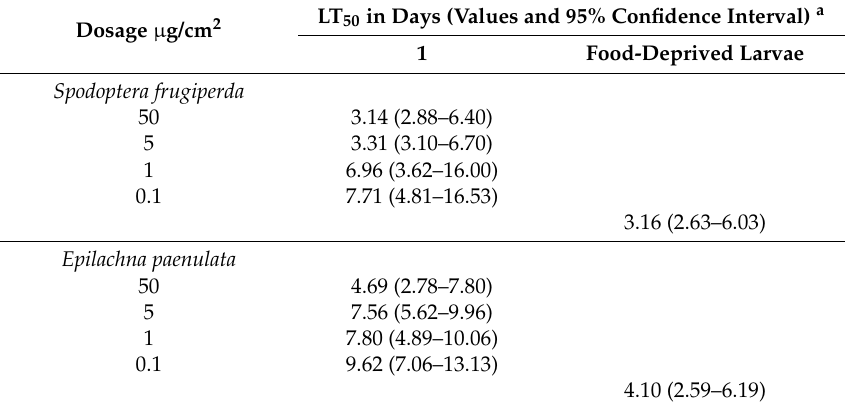
Figure 3. Cumulative mortality of S. frugiperda larvae fed with leaves treated with 1 at different concentrations. All treatments were in triplicate ( n = 10). Starved represents food-deprived treatment. Error bars show standard deviation; where error is not shown, it is smaller than the symbol.